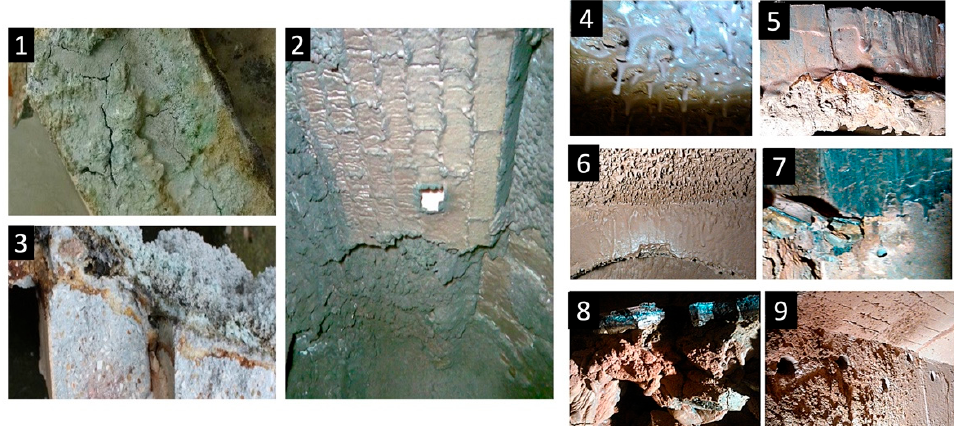
Figure 1. Degradation of refractory materials in boilers after combustion of different types of biomasses [8,9]: ( 1 ) the damage to refractory materials after 1 year of the combustion of wood chips; ( 2 ) the furnace vault after 1.5 years of the combustion of chipboard; ( 3 ) the corroded part of refractory samples after 2 years of combustion of plant biomass, and ( 4 – 9 ) the presentation of the defects of the refractory lining after the combustion of biomass for 10 years of operation.